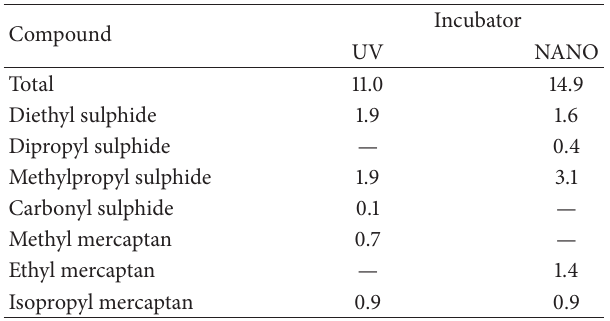
Table 12: Concentration of sulphur compounds in the air inside the incubators on the 17th day of incubation [ 𝜇 g/m 3 ].